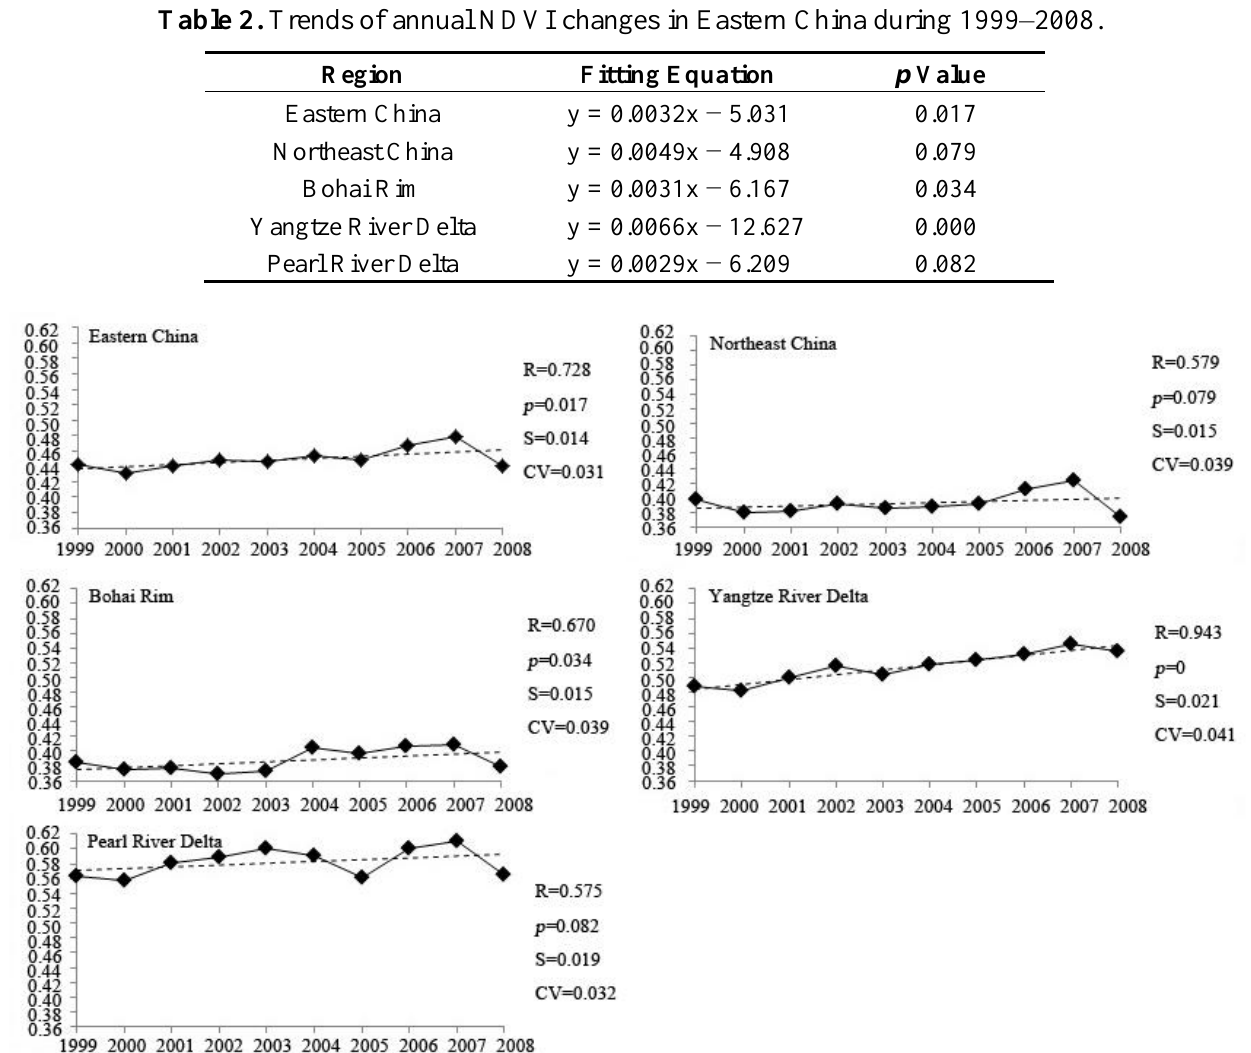
Figure 3. Trends of annual NDVI changes in Eastern China during 1999–2008, where R is the Pearson correlation coefficient; p is the significance level; S is the Standard deviation; and CV is the variable coefficient; sample size (n) is